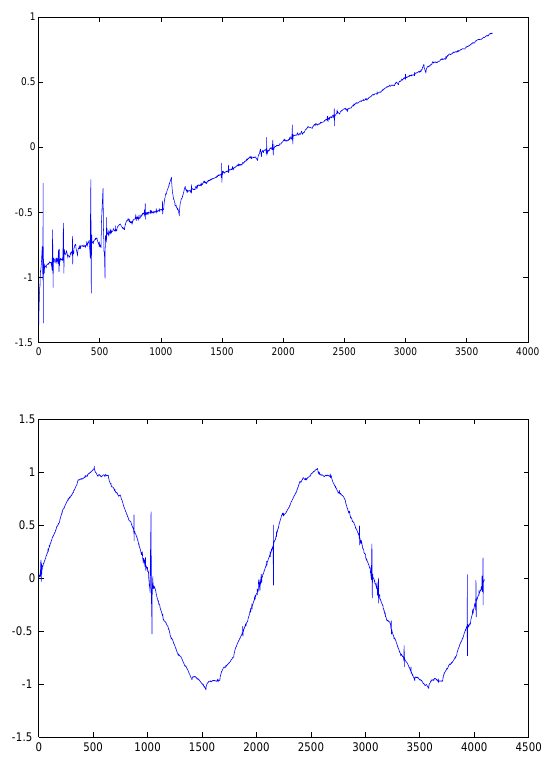
Multsitable motion (blue) with superimposed linear alpha function (black)